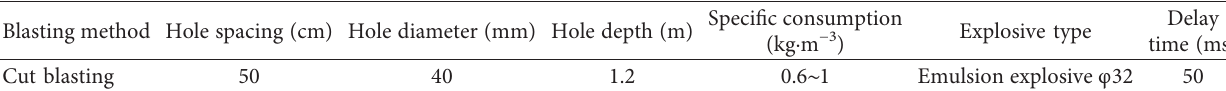
Table 4: Parameters of tunnel